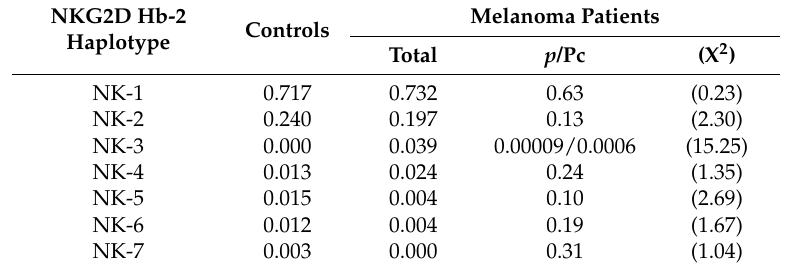
Table 5. Frequency of NKG2D Hb-2 haplotypes in healthy controls and melanoma patients.